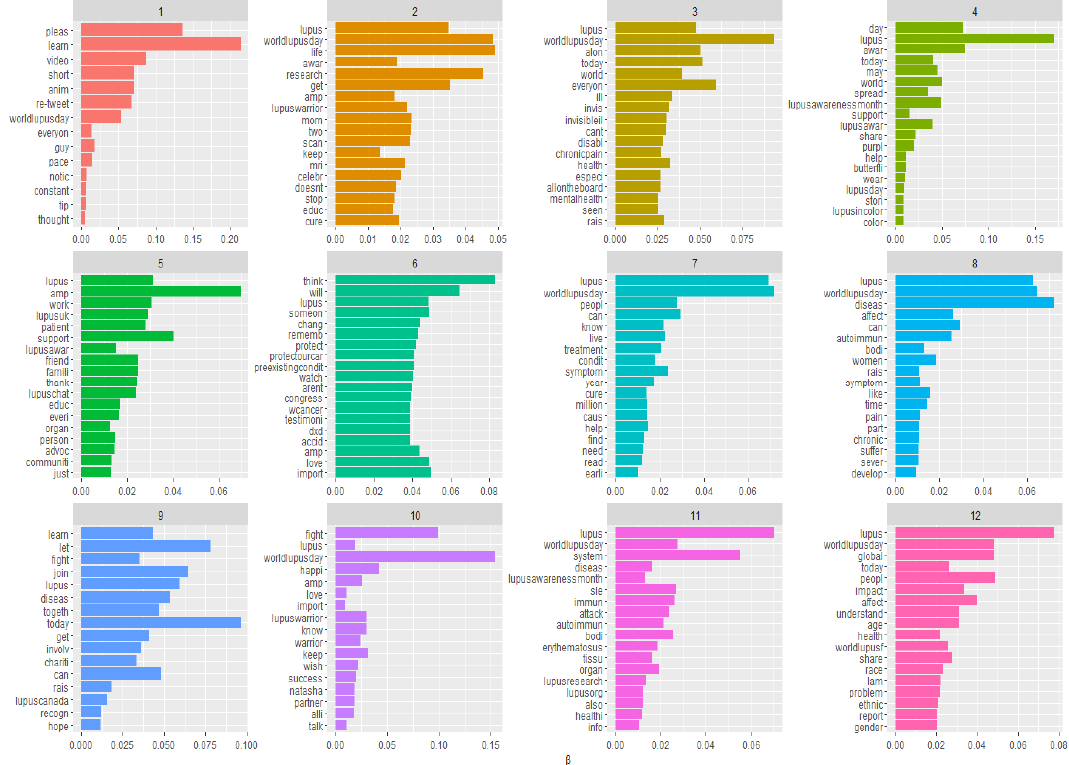
Figure 3. Topics and themes identified in the tweet text corpus.